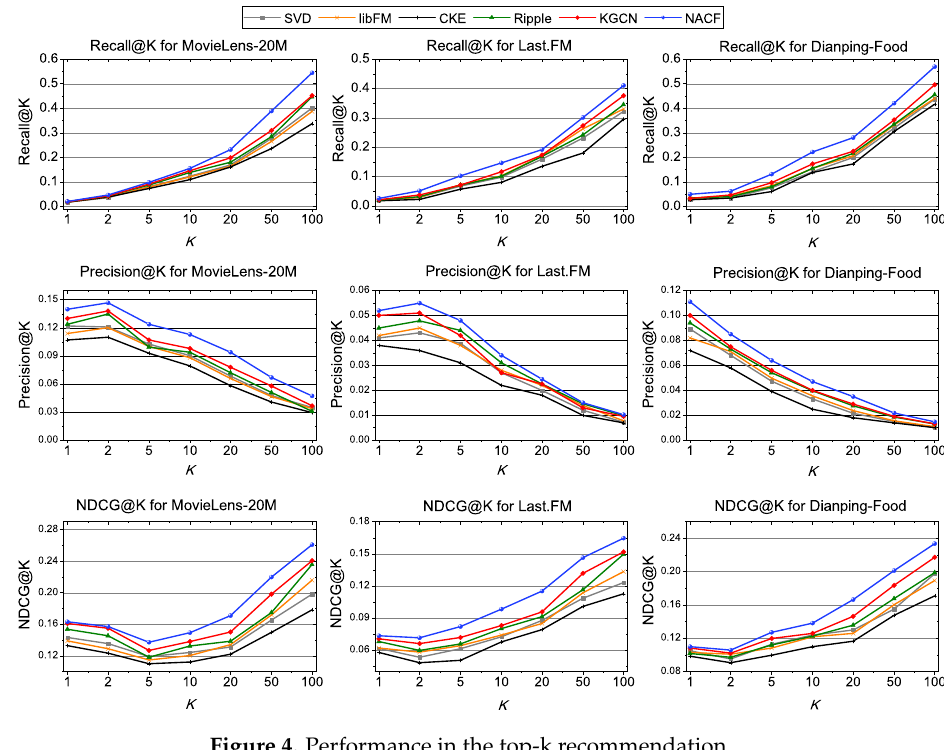
Figure 4. Performance in the top-k recommendation. Table 4. Performance in